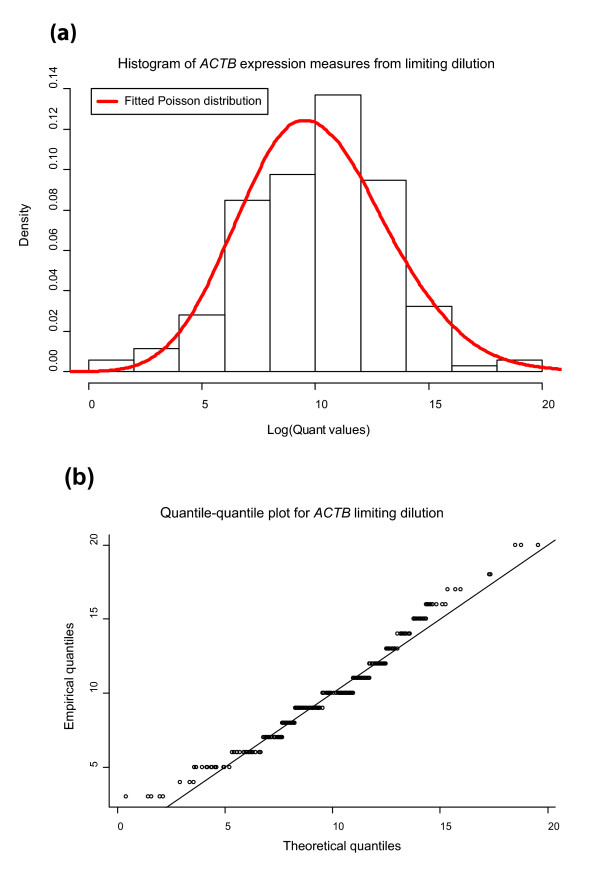
(a) Histogram of gene expression values (log(quant values)) of ACTB obtained from the limiting dilution experiment. A fit to paired Poisson distributions also suggests that these data represent expression from a single cell rather than one or more cells. (b) Quantile-quantile plot.